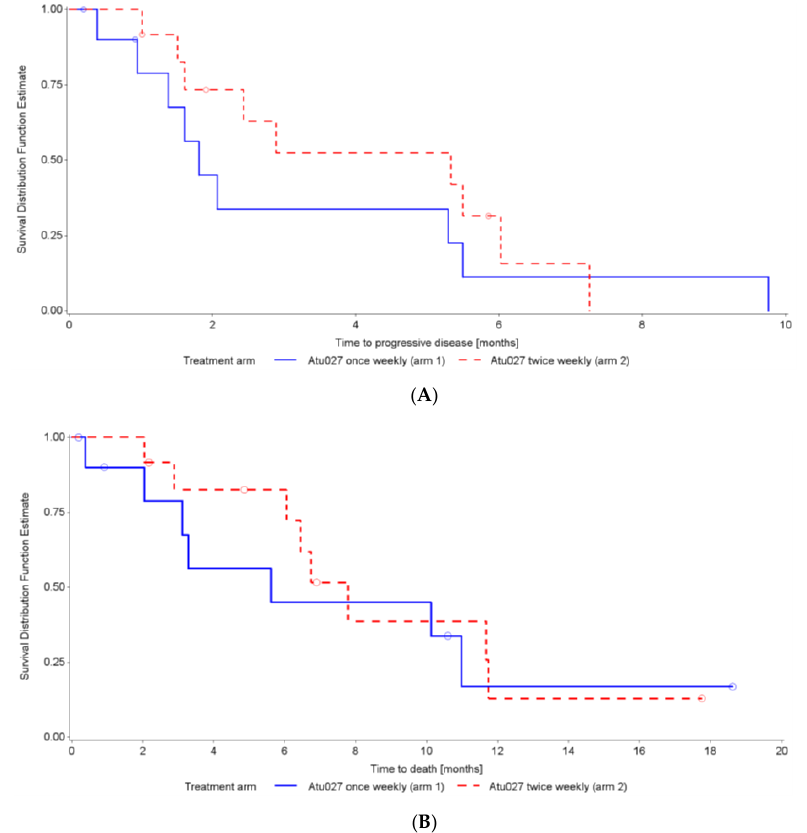
Figure 3. Kaplan–Meier survival curves for progression-free survival ( A ) and overall survival ( B ) (Safety analysis set, N = 23).